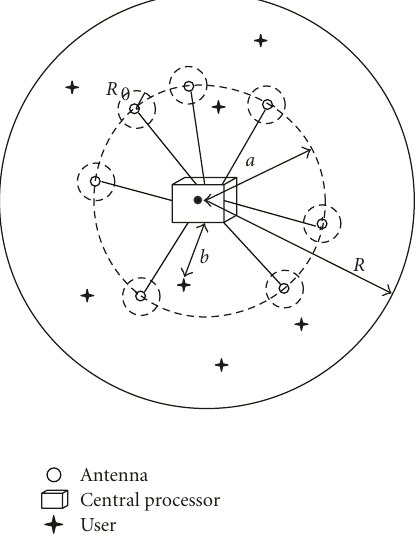
Figure 1: Illustration of